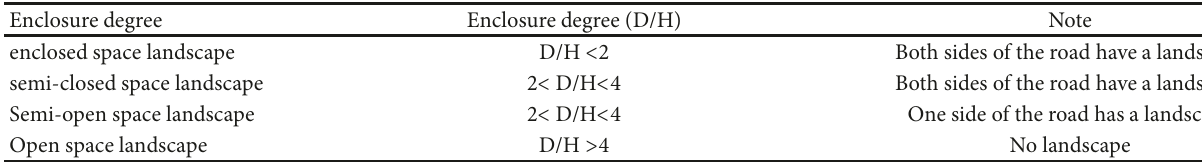
Table 1: Classification of highway landscapes.